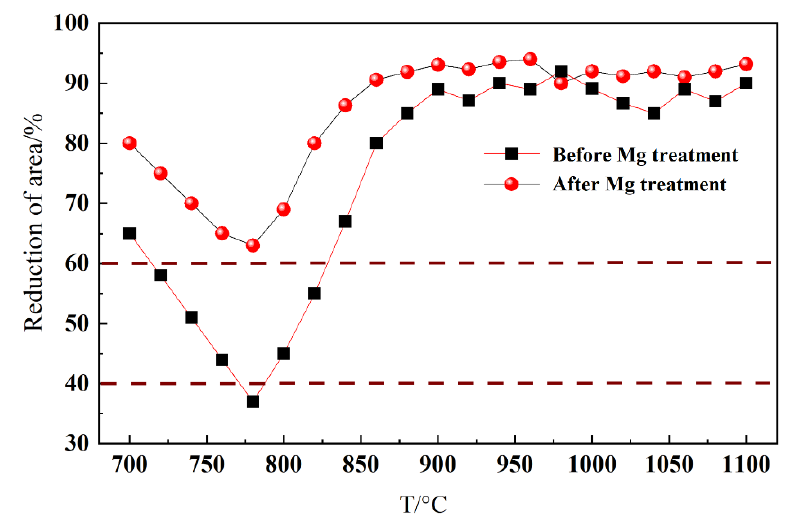
Figure 6. Variation curve of the reduction of area before and after magnesium treatment.